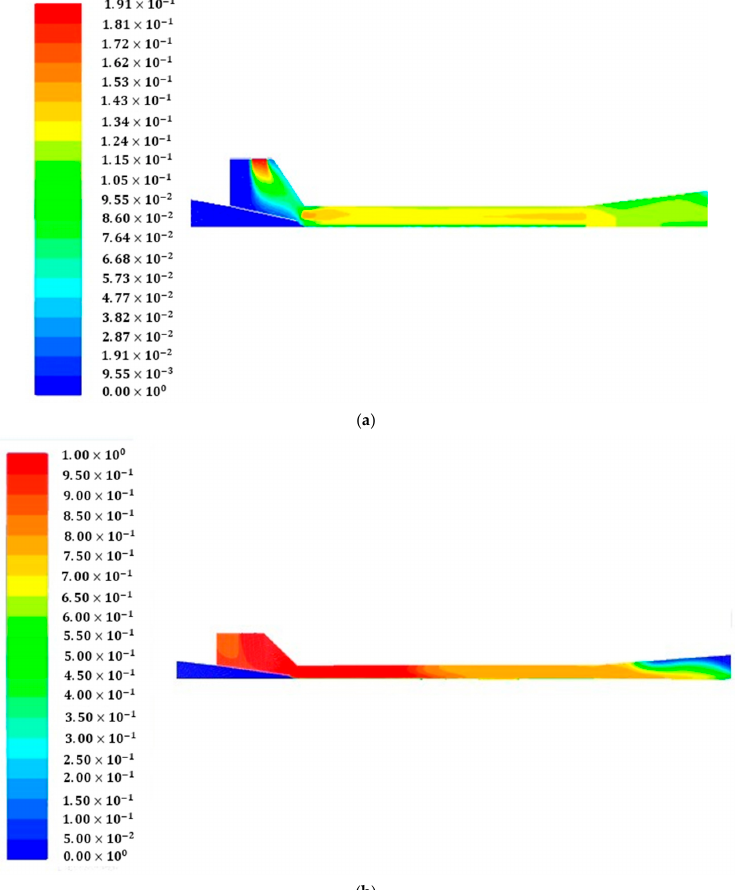
Figure 16. The mass fraction contour of CO 2 in the gas phase along the ejector for ( a ) 0 Pag output pressure and ( b ) 2000 Pag output pressure.